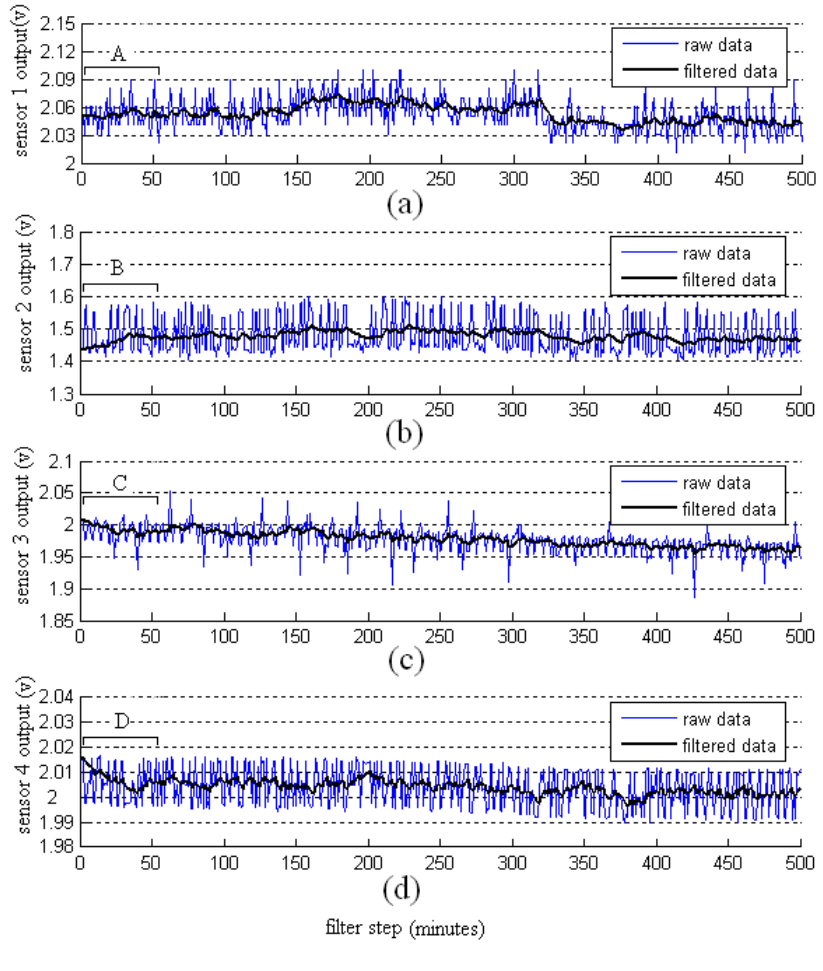
Figure 7. Filter results of the four sensors. (a) Sensor 1 at variance ratio